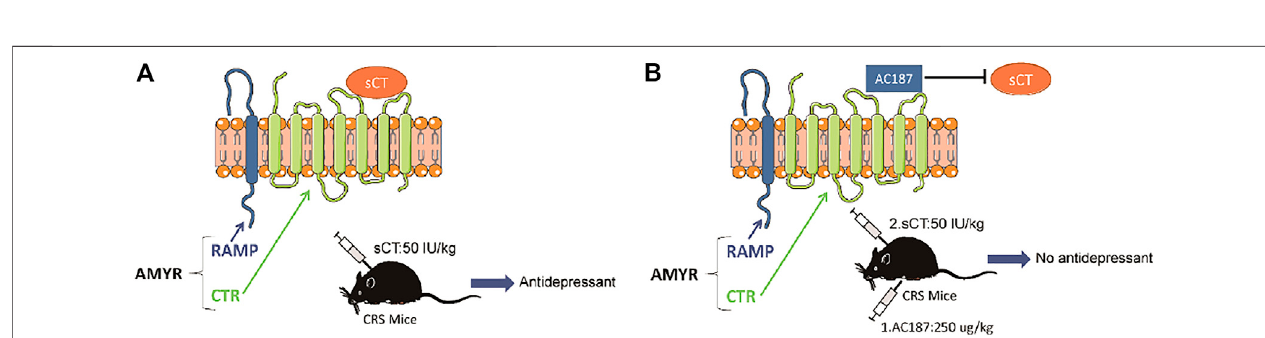
FIGURE8| WorkingmodelofthesCTantidepressanteffectbyactivatingamylinreceptorsinCRSmice.sCTcanactivateAMYRstoplayanantidepressantrole (A) . AC187 eliminates the antidepressant effect of sCT (B) . sCT, salmon calcitonin; CRS, chronic restraint stress; AMYRs, amylin receptors.